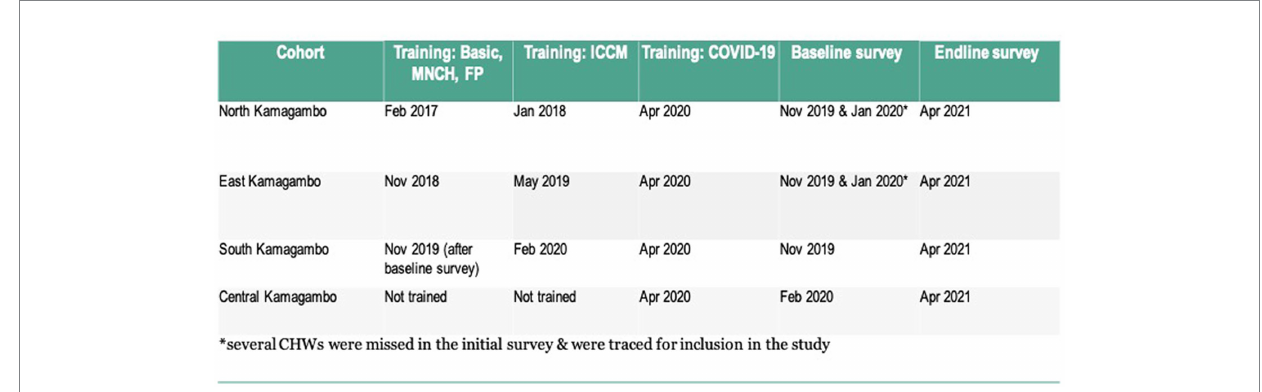
FIGURE 2 Study timeline. *Several CHWs were missed in the initial survey & were traced for inclusion in the